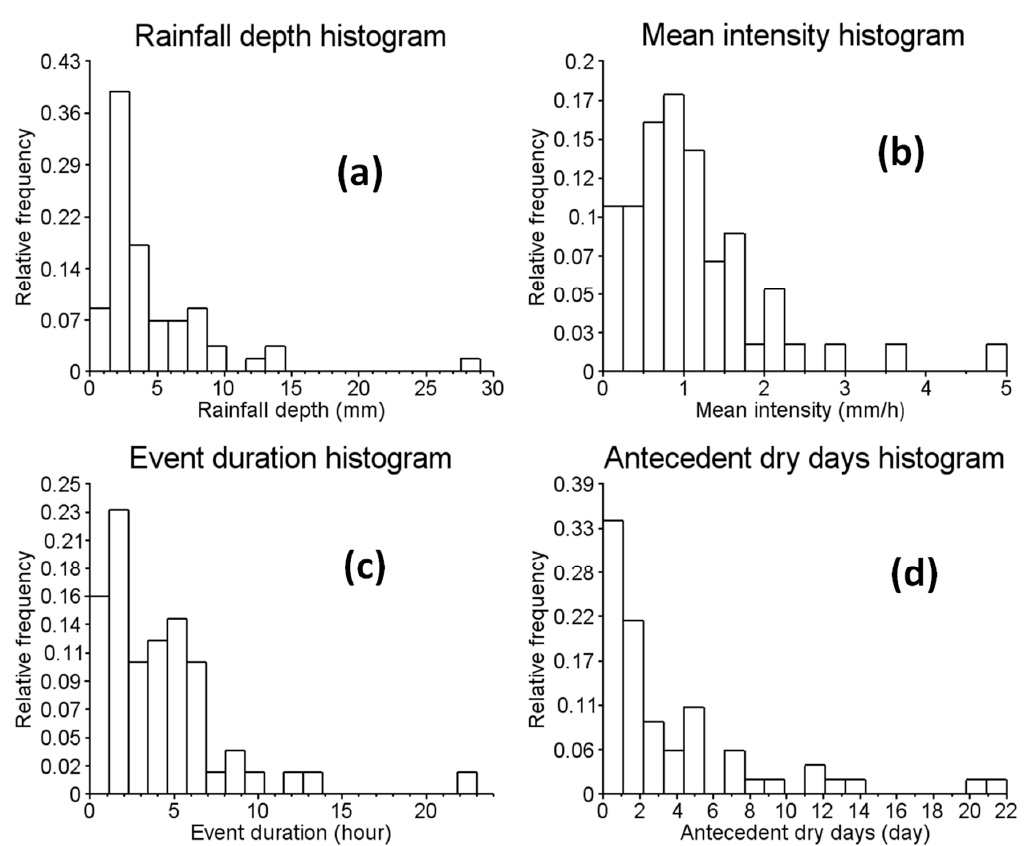
Figure 3. Histogram of rainfall event characteristics over the entire period: ( a ) rainfall depth; ( b ) mean intensity; ( c ) event duration; and ( d ) antecedent dry days.